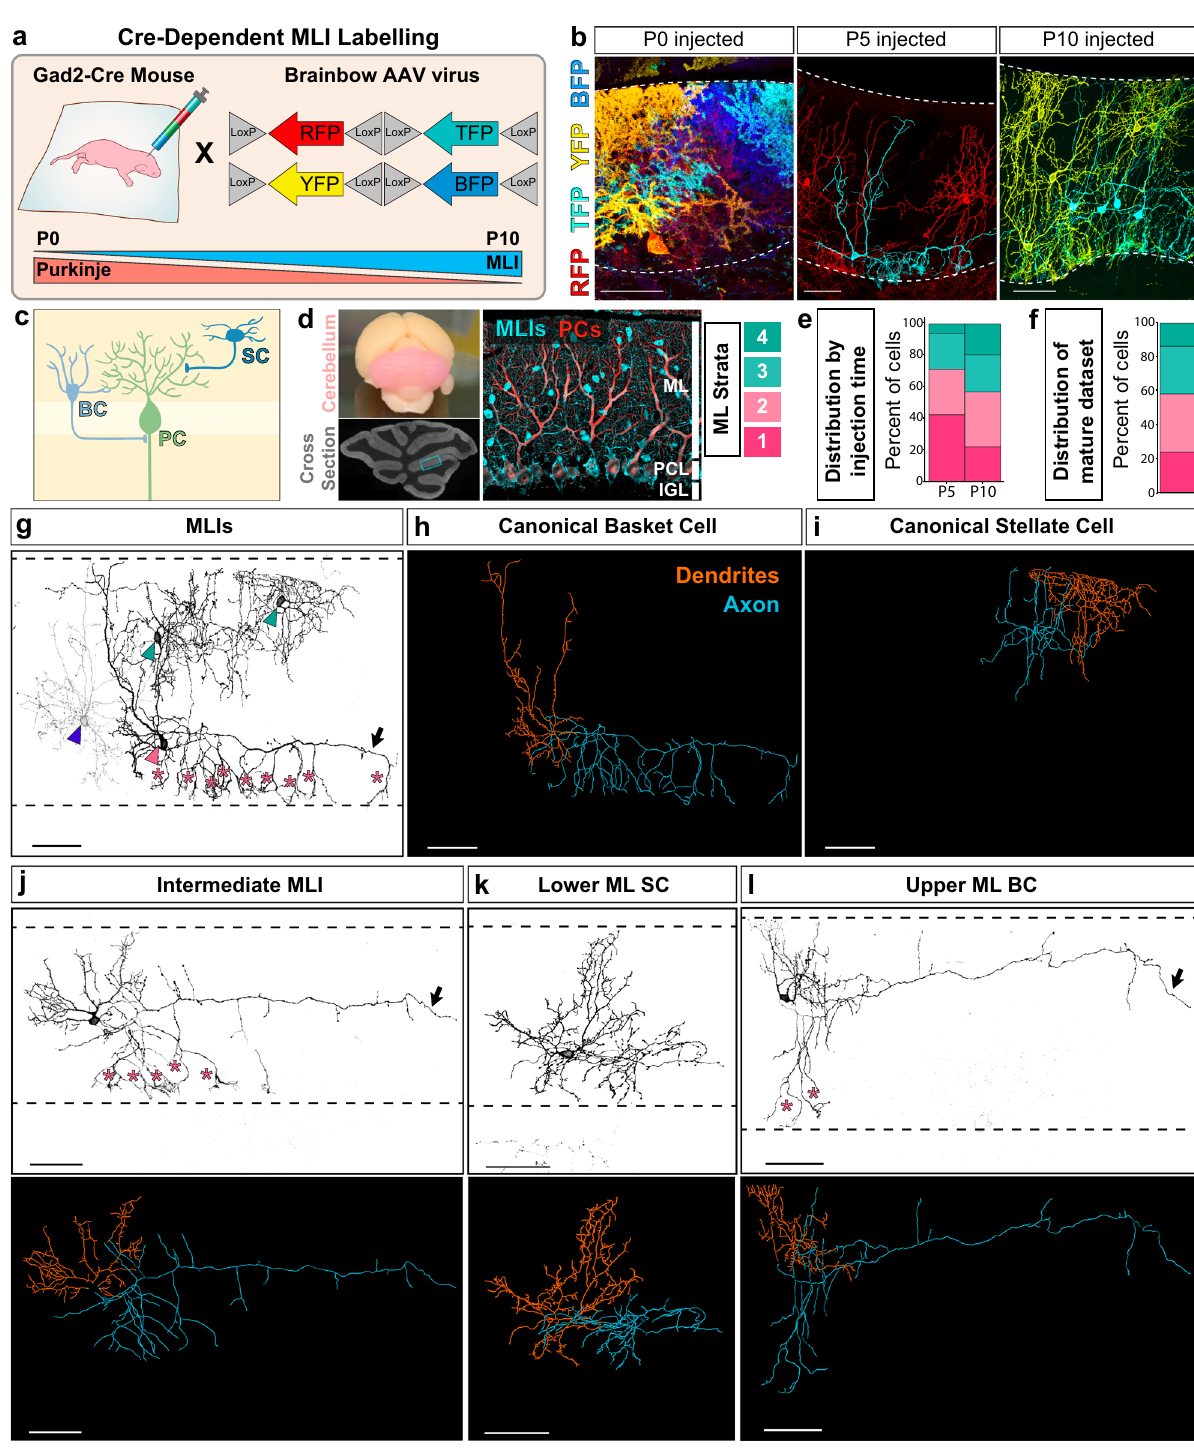
branched, radial dendritic arbors (25 of 79 cells; Fig. 1g, i).